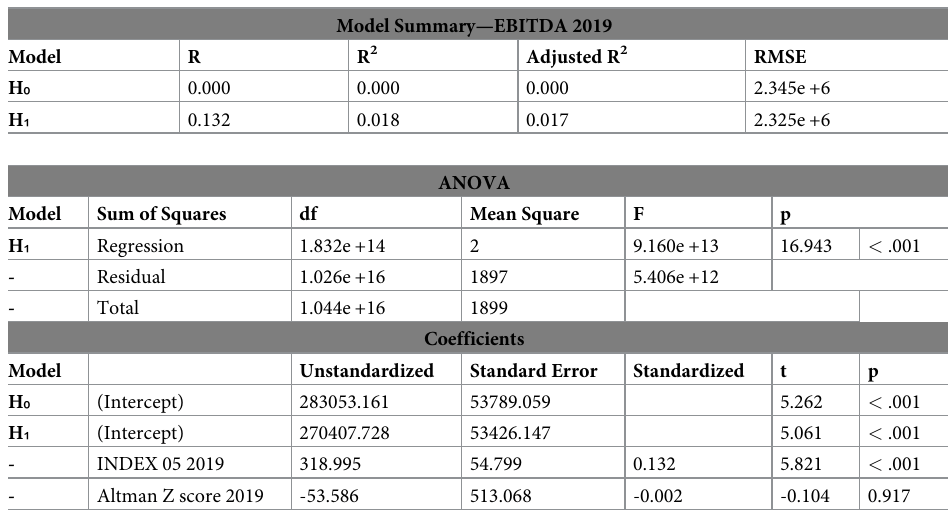
Table 9. Model Summary—EBITDA 2019.